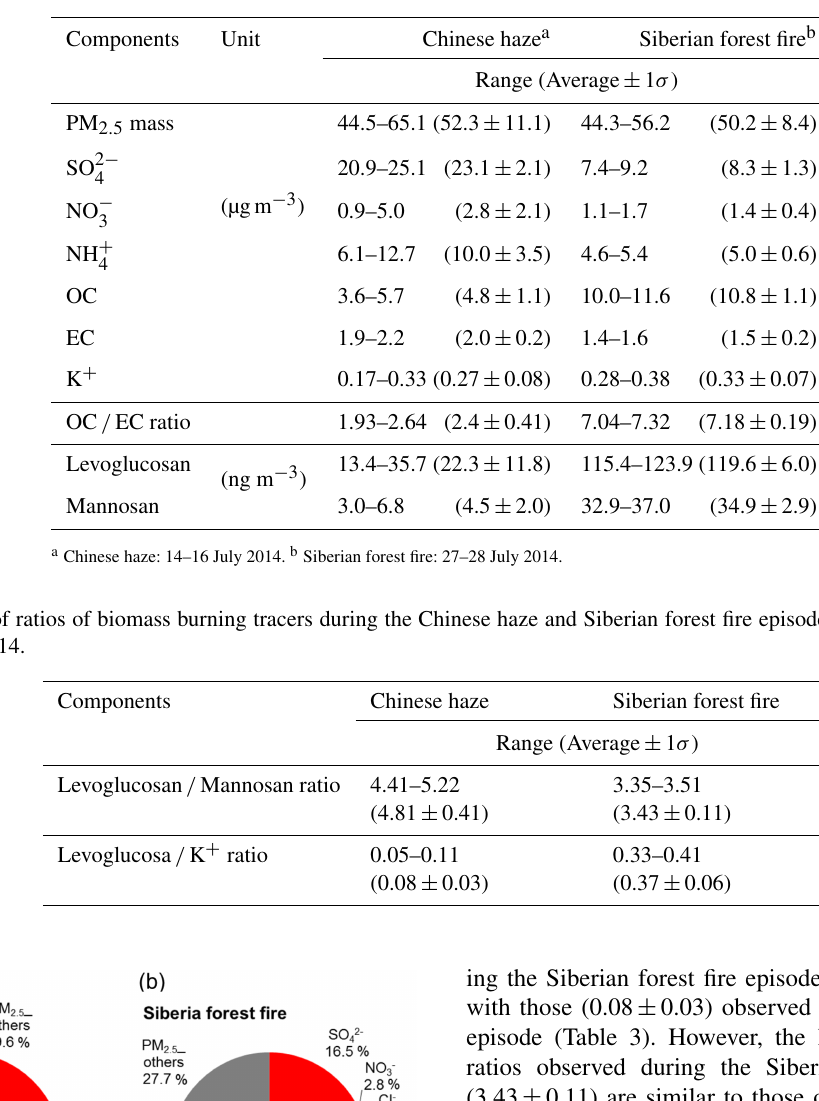
Table 2. Summary of fine particle (PM 2 . 5 ) mass, and organic and inorganic chemical composition of PM 2 . 5 particles during the Chinese haze and Siberian forest fire episodes measured at Daejeon, Korea during summer 2014.